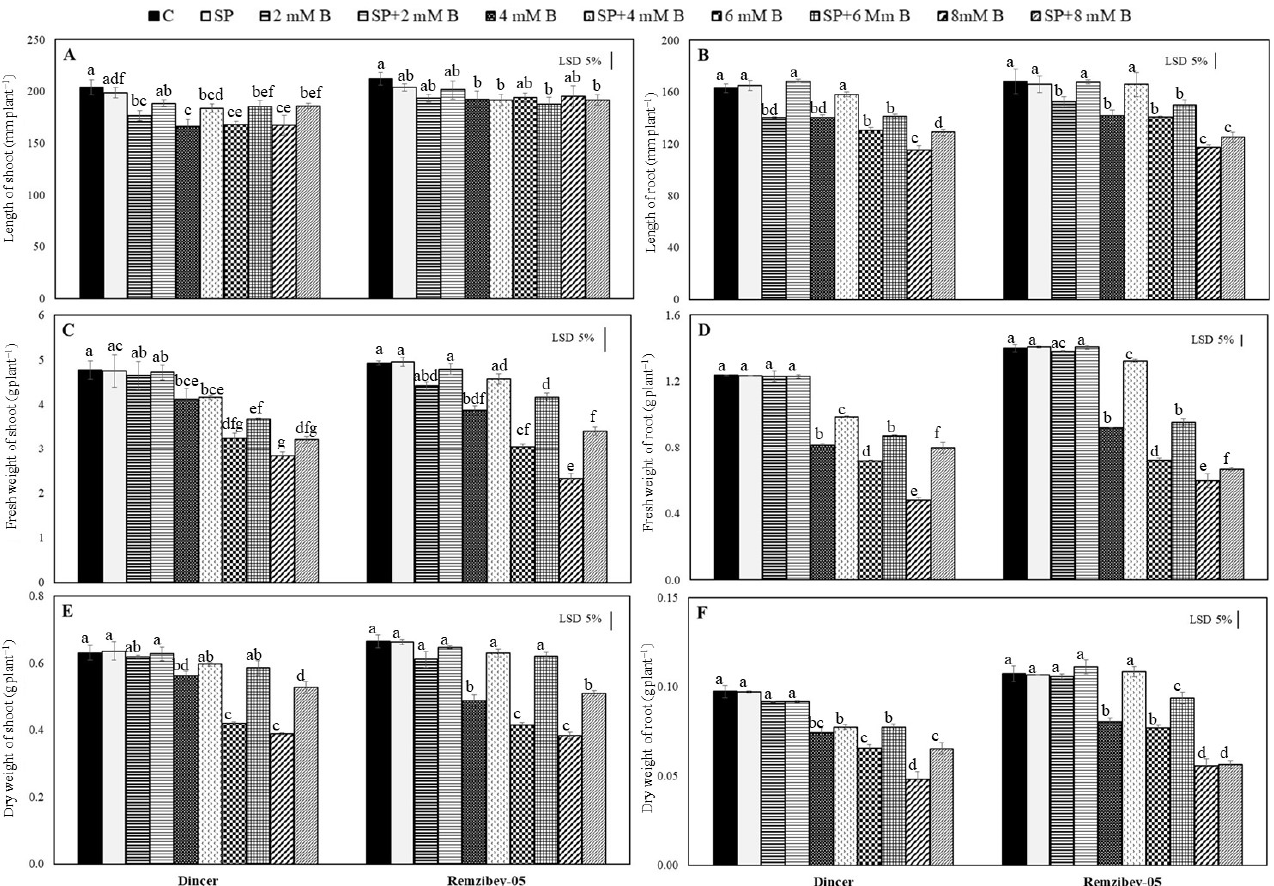
Figure 1. Length of shoot ( A ) and root ( B ), fresh weight of shoot ( C ) and root ( D ), and dry weight of shoot ( E ) and root ( F ) of safflower cultivars submitted to toxic B with or without SP. The values are presented as the mean ± standard error (SE), n = 3. The bars and different letters indicate significant difference between treatments and cultivars at p < 0.05 according to the LSD test.